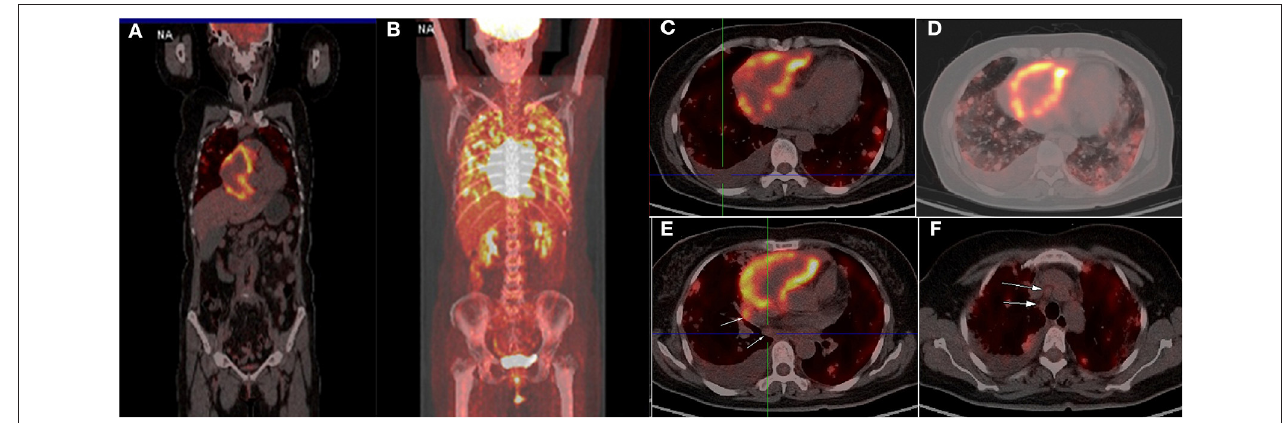
FIGURE 3 | Positron emission tomography scan showed a heterogeneous mass at the right margin of pericardium with circular hypermetabolic uptake of fluorodeoxyglucose-18, poorly demarcated from the right atrium (A–C) . Distant metastases were found in both lungs, bilateral pleural (A,D) , nodules in hilar and mediastinal lymph (E,F) (arrow).